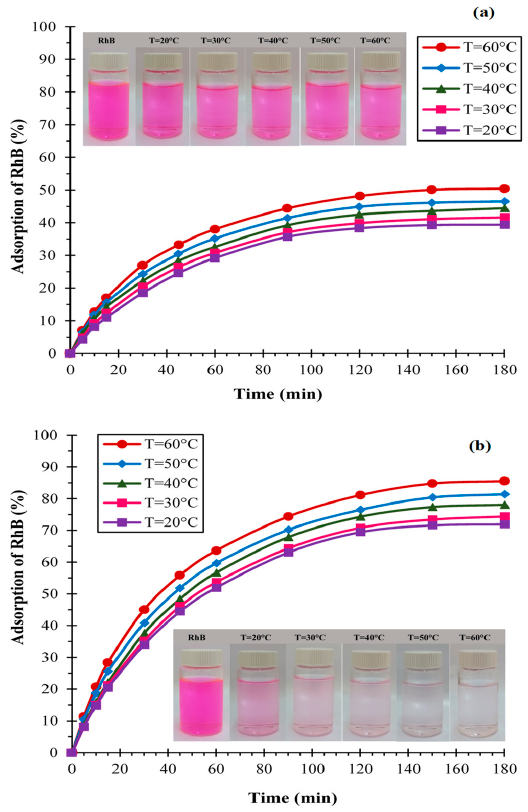
Figure 3. Evolution of the adsorption of RhB dye at different temperatures on ( a ) KS44 ‐ 0 and ( b ) KS44 ‐ 20.